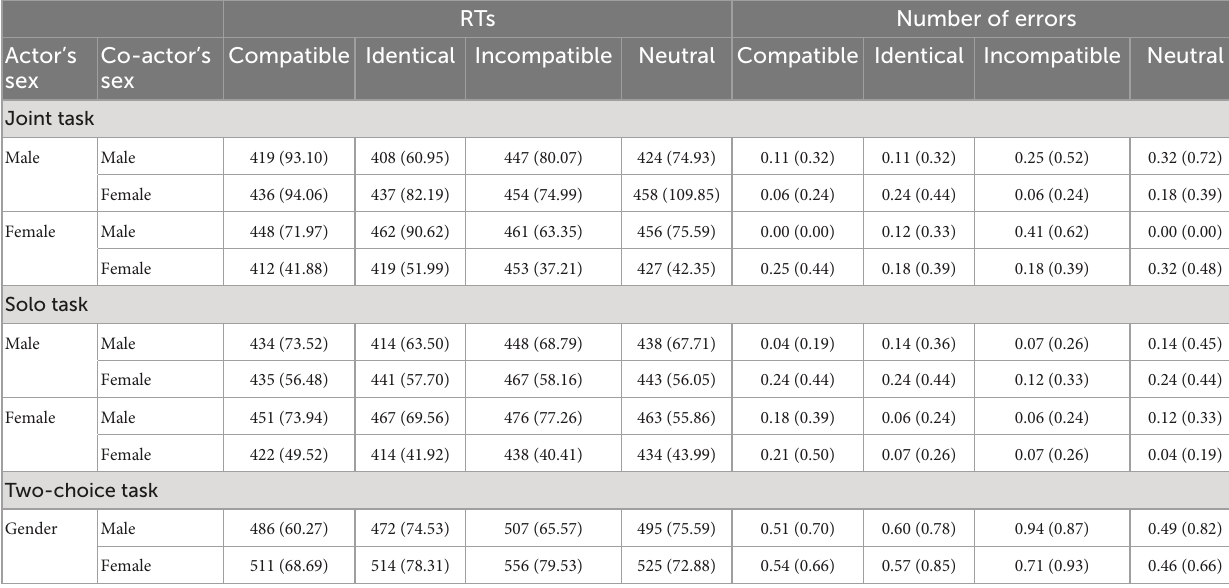
TABLE 1 The means (and relative SDs) of response times (RTs), in ms, and number of errors for each flanker type in joint and solo conditions are displayed for each type of sex